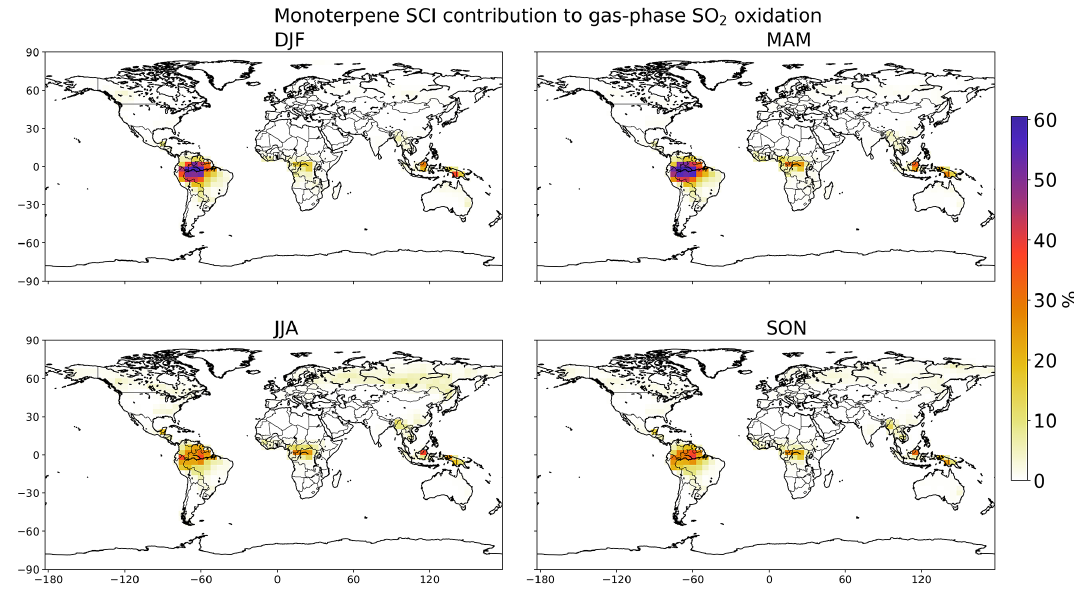
Figure 8. Seasonal SO 2 oxidation by monoterpene SCIs as percentage of total gas-phase SO 2 oxidation in the surface